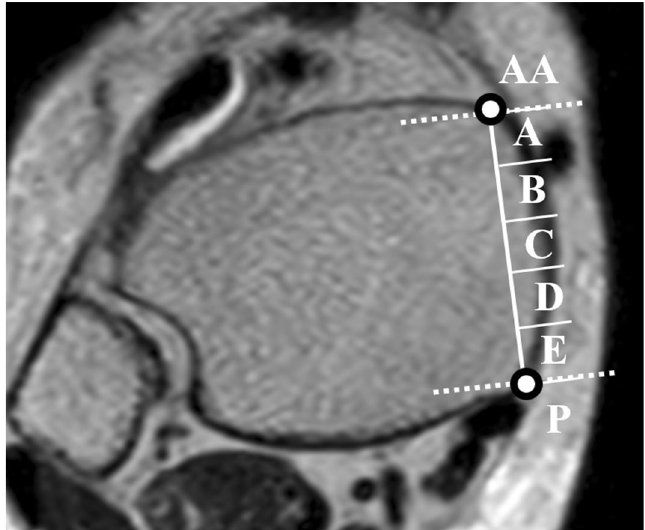
Figure 2. Seven segments used to determine the location of the great saphenous vein. Using an axial image, we divided the region from the anterior edge of the tibia to the posteromedial edge into five segments (A, B, C, D, and E), and designated the segment that was anterior to the anterior edge as ‘AA’ and the segment that was posterior to the posterior edge as ‘P.’ The course of the great saphenous vein through these segments at heights 1–4 described in Fig. 1 was evaluated.